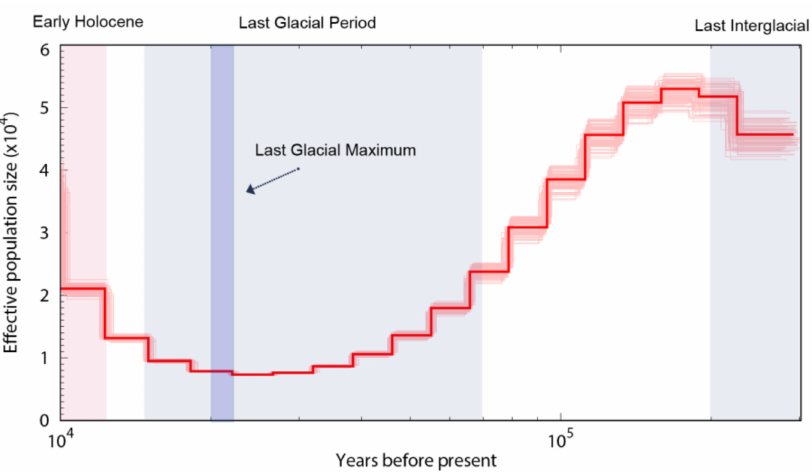
Figure 10. Demographic history of the shimofuri goby in this study. Note: PSMC estimates of demographic changes in effective population size (Ne) over time inferred from the draft genome sequences of the shimofuri goby. Thick lines represent the median and thin light lines correspond to 100 rounds of